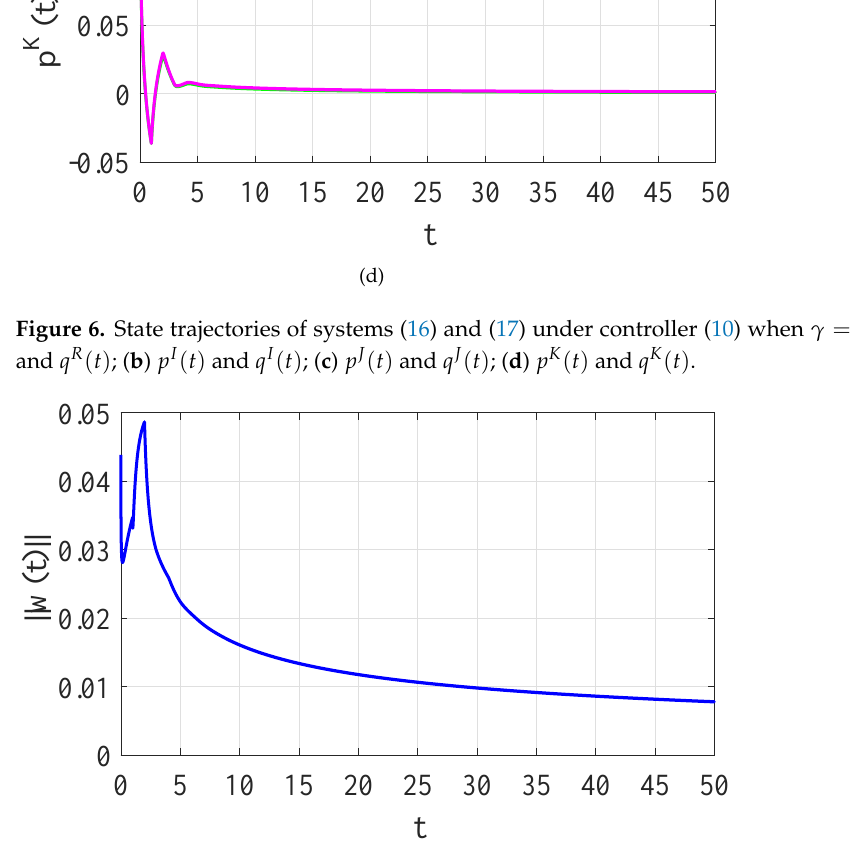
Figure 7. Error norm (cid:107) w ( t ) (cid:107) under controller (10) when γ =